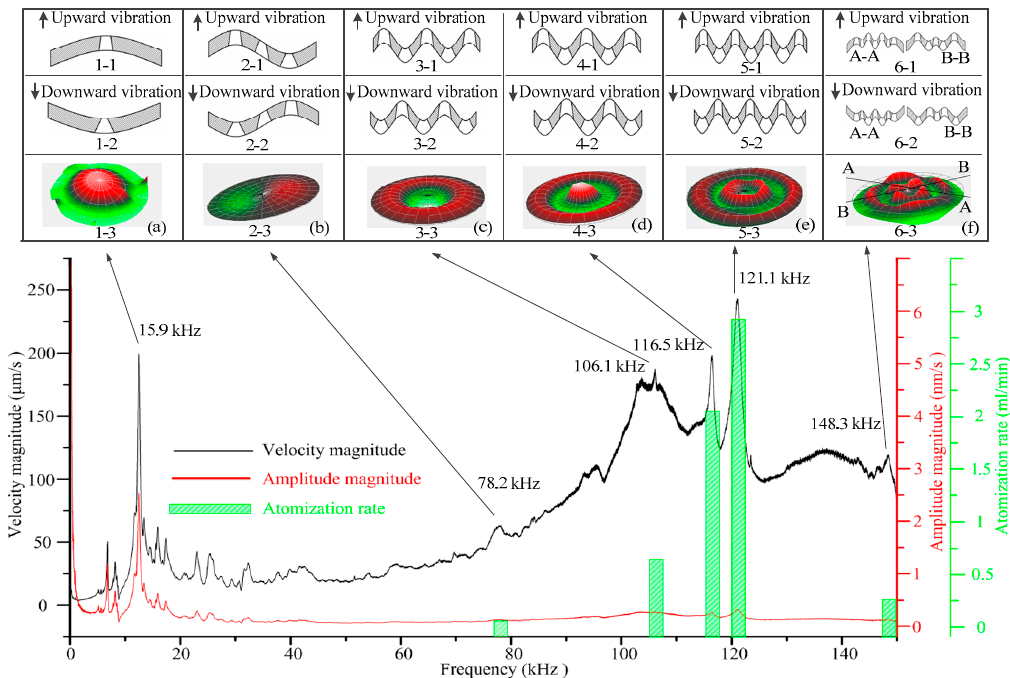
Figure 10. Frequency sweep curves of the vibration velocity and amplitude, vibration modes of resonance points, deformation diagram of piezoelectric oscillator and atomization rates at the resonance points. (a)-(f) Vibration modes of resonance points 1–6 and the corresponding tapered aperture deformation diagrams at these points.